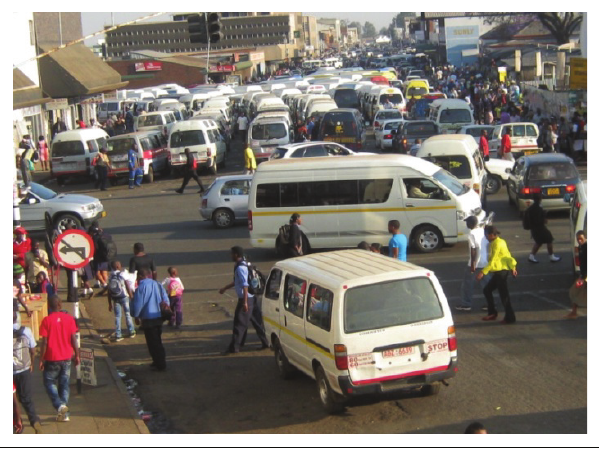
FIGURE 2: Kombis operating in Zimbabwean cities.